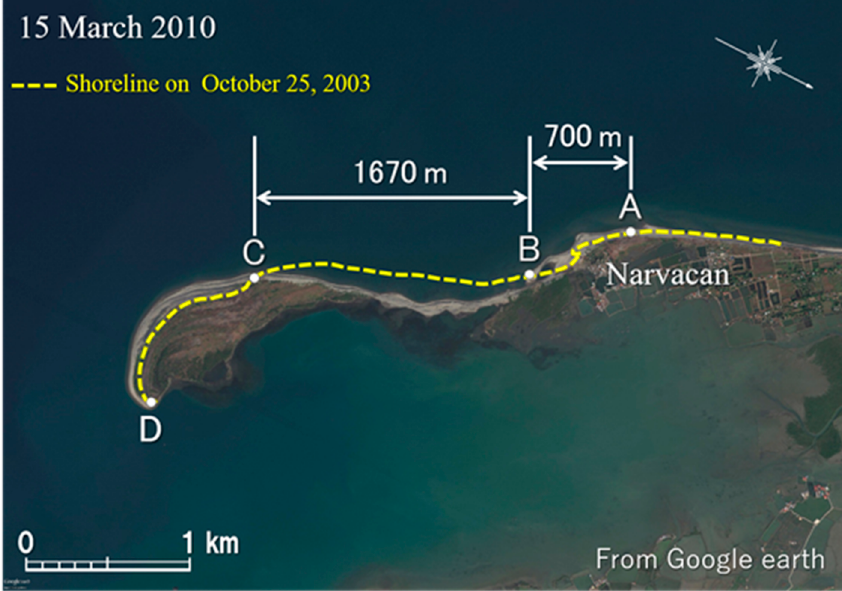
Figure 23. Satellite image around the sand spit at Santo Tomas (15 March 2010).